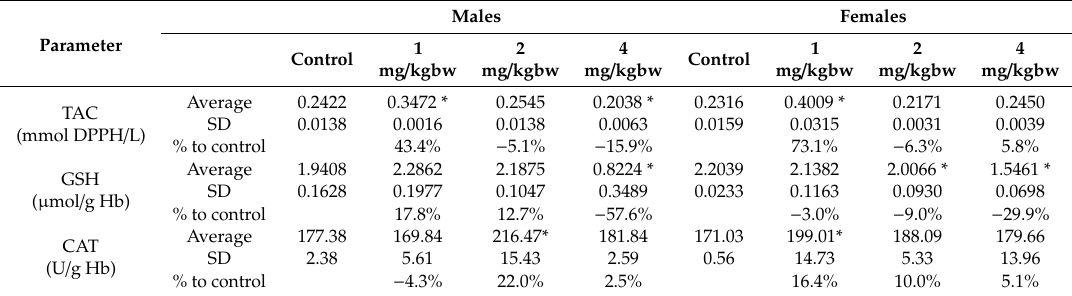
Table 2. Markers at 28 days after exposure to di ff erent concentrations of